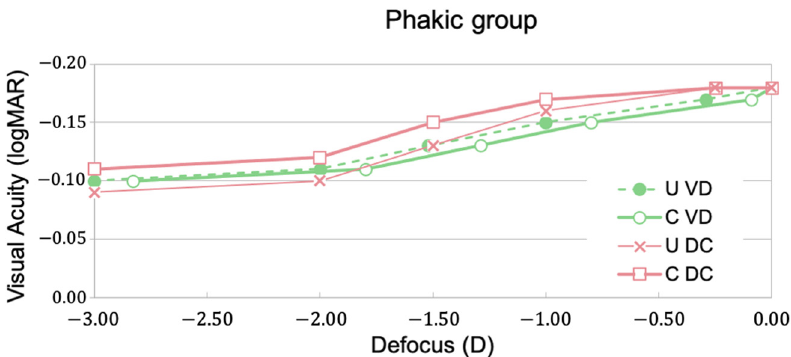
Figure 3 . Visual acuity (logMAR) versus defocus that was obtained with VD and DC methods for the phakic group (with accommodation preserved): uncorrected (U) results and results that were corrected (C) for the starting position of the chart (5 m) and the diminution of the minus lenses. All the measurements were taken with the best distance correction.